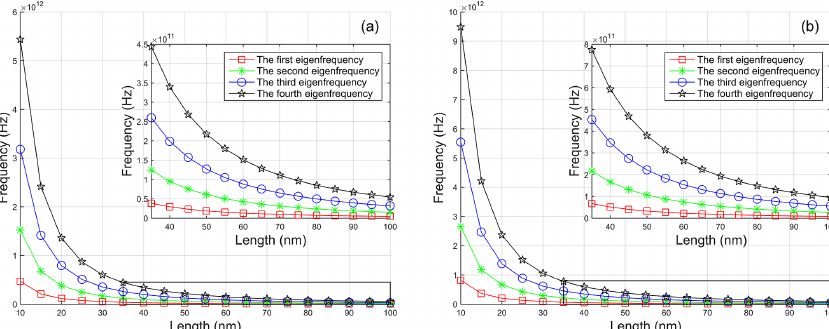
Figure 8. The first four eigenfrequencies of fixed–simply supported armchair nanotubes with nonlocal parameter µ = 0 . 3, (a) nanotube with chirality ( n , m ) = (10, 10) and diameter D = 1 . 356nm, (b) nanotube with and chirality ( n , m ) = (20, 20), diameter D = 2 .